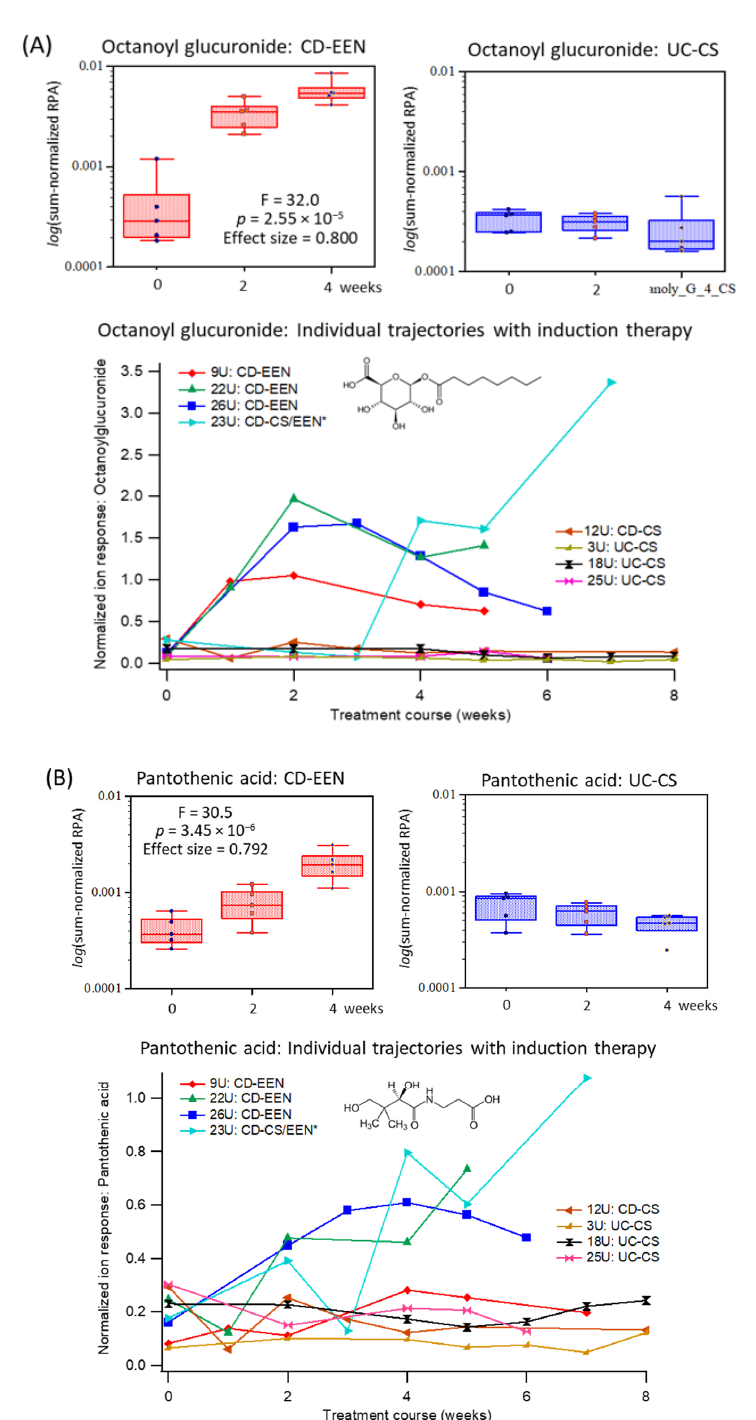
Figure 3. Top ‐ ranked urinary biomarkers associated with adherence to EEN among pediatric IBD patients ( n = 10), namely ( A ) octanoylglucuronide and ( B ) pantothenic acid. Box ‐ whisker plots show a specific elevation in the excretion of both